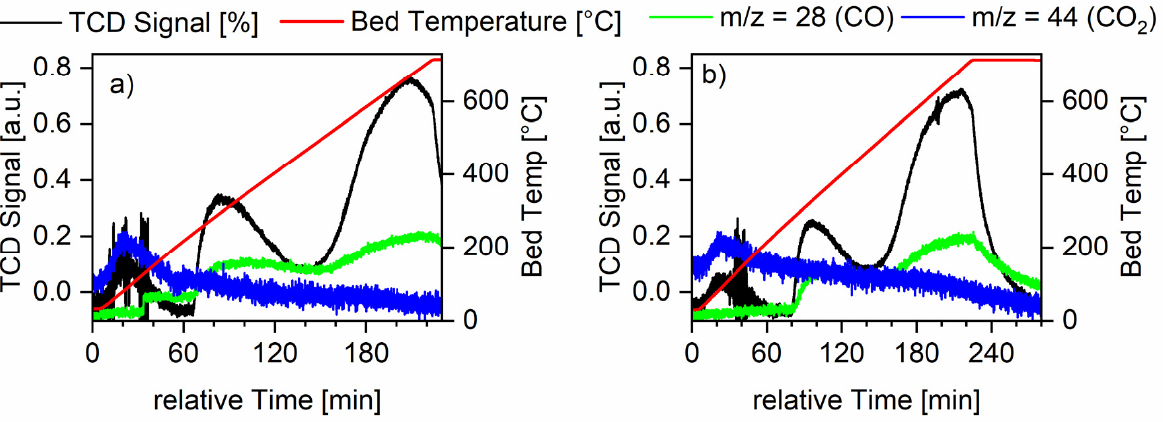
Figure 6. Temperature-programmed desorption of CO measurements for all Ru-XX-3 catalysts. The red line shows the temperature measured at the catalyst bed, the green line shows the mass spectrometer signal for the m/z value of CO, and the blue line shows the mass spectrometer signal for the m/z value for CO 2 . Furthermore, the black line shows the TCD signal. Graph ( a ) shows the measurements for the Ru-NO-icr. catalyst and Graph ( b ) shows the measurements for the Ru-Cl-icr. catalyst.